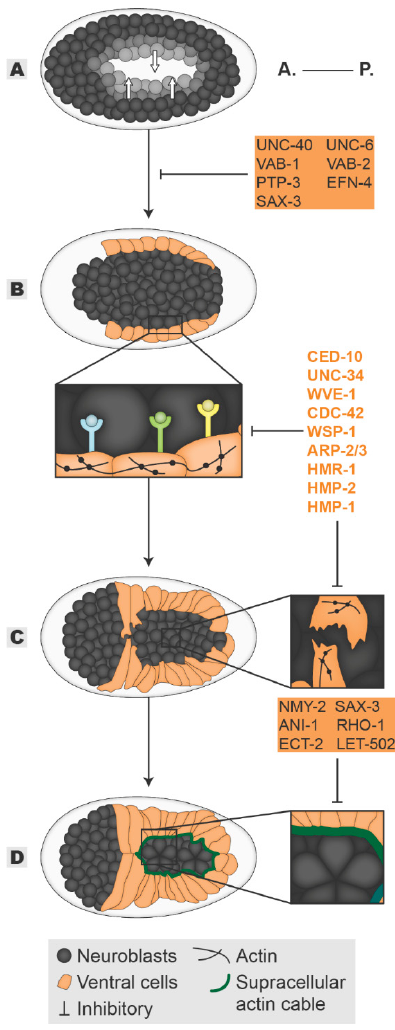
Figure 2. Ventral enclosure. Ventral enclosure encompasses the following “steps”: In the end of gastrulation, the neuroblasts close the ventral cleft ( A ) allowing the migration of the ventral epidermal cells ( B ). The “leading cells” initiate the migration ( C ) followed by the “pocket cells” ( D ), enclosing the embryo in a continuous epidermal layer. In each ventral enclosure “step”, players in grey and highlighted in orange are required in neuroblasts and epidermis, whereas players in orange are required in the epidermal tissue. All inhibitory signs are indicative of the outcome of the absence of a player. Embryos oriented with anterior (A.) on the left and posterior (P.) on the